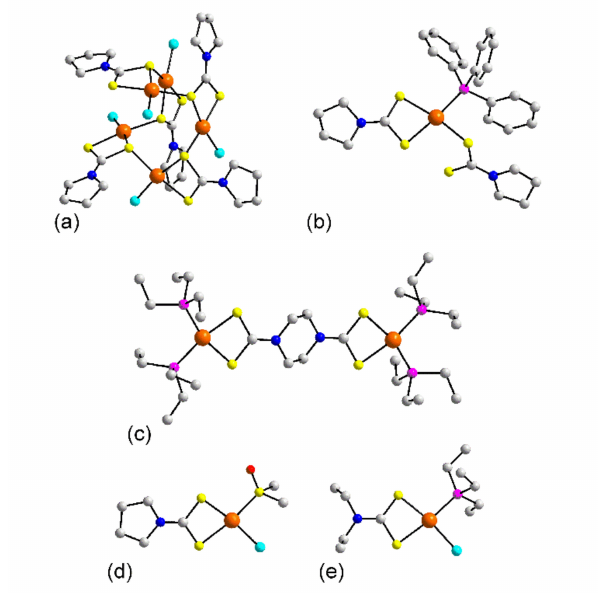
Figure 13. Molecular structures of platinum dithiocarbamate complexes: ( a ) [Pt( L 57 )Cl] 5 in the crystal of 233 , ( b ) (PPh 3 )Pt( η 1 - L 57 )( η 2 - L 57 ) in 234 , ( c ) {[(PEt 3 ) 2 Pt] 2 ( L 74 )} 2+ in 235 , ( d ) Pt( L 57 )Cl((CH 3 ) 2 SO) ( 237 ), and ( e ) (PEt 3 )Pt( L 24 )Cl ( 238